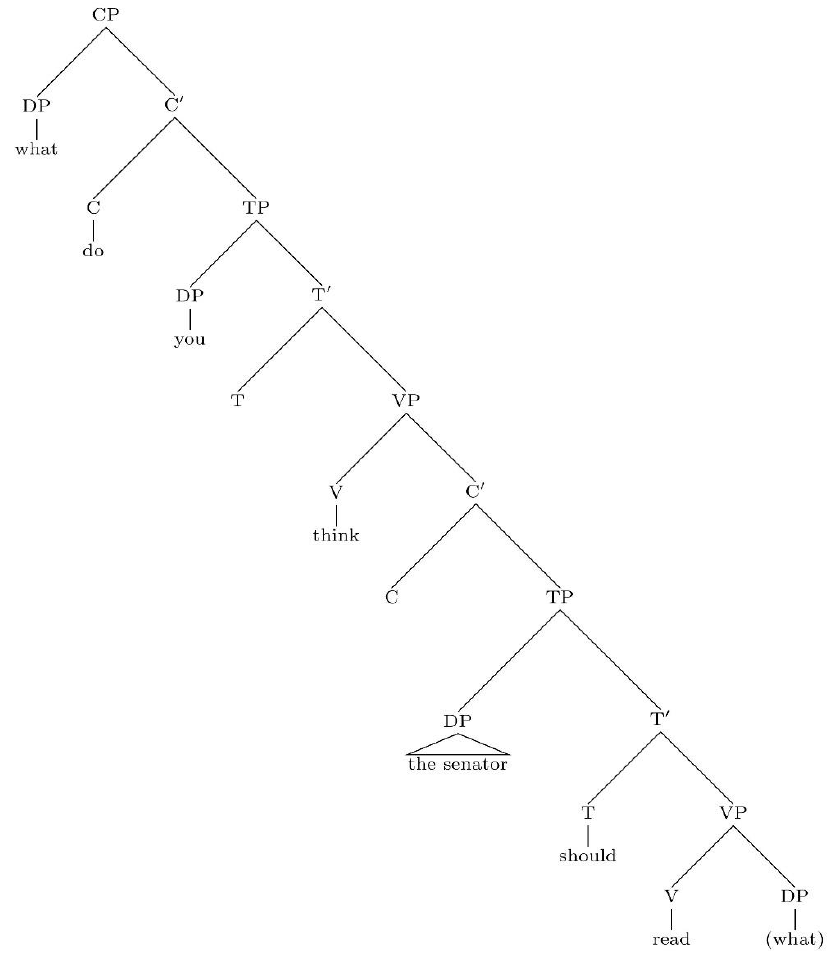
Figure 19. Derived tree for ‘what do you think the senator should read?’